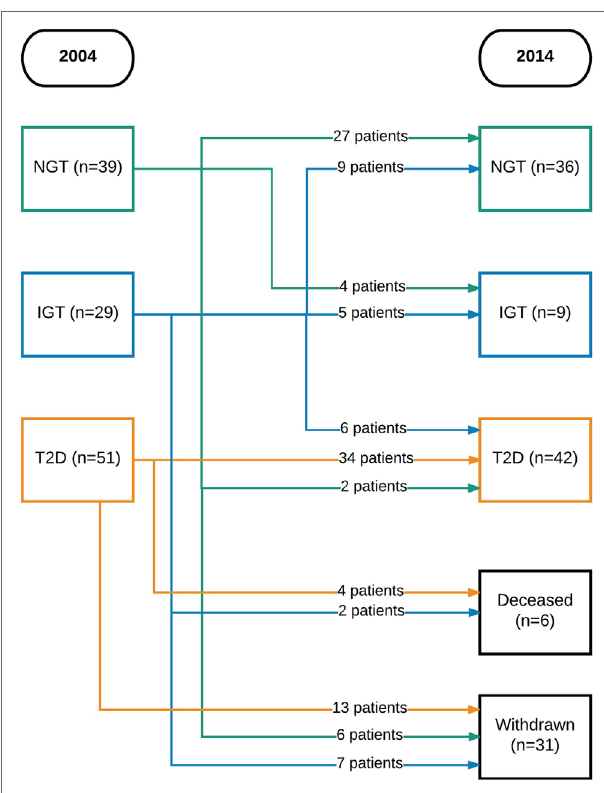
FigUre 1 | Flowchart of patients over time. NGT, normal glucose tolerance; IGT, impaired glucose tolerance; T2D, type 2 diabetes